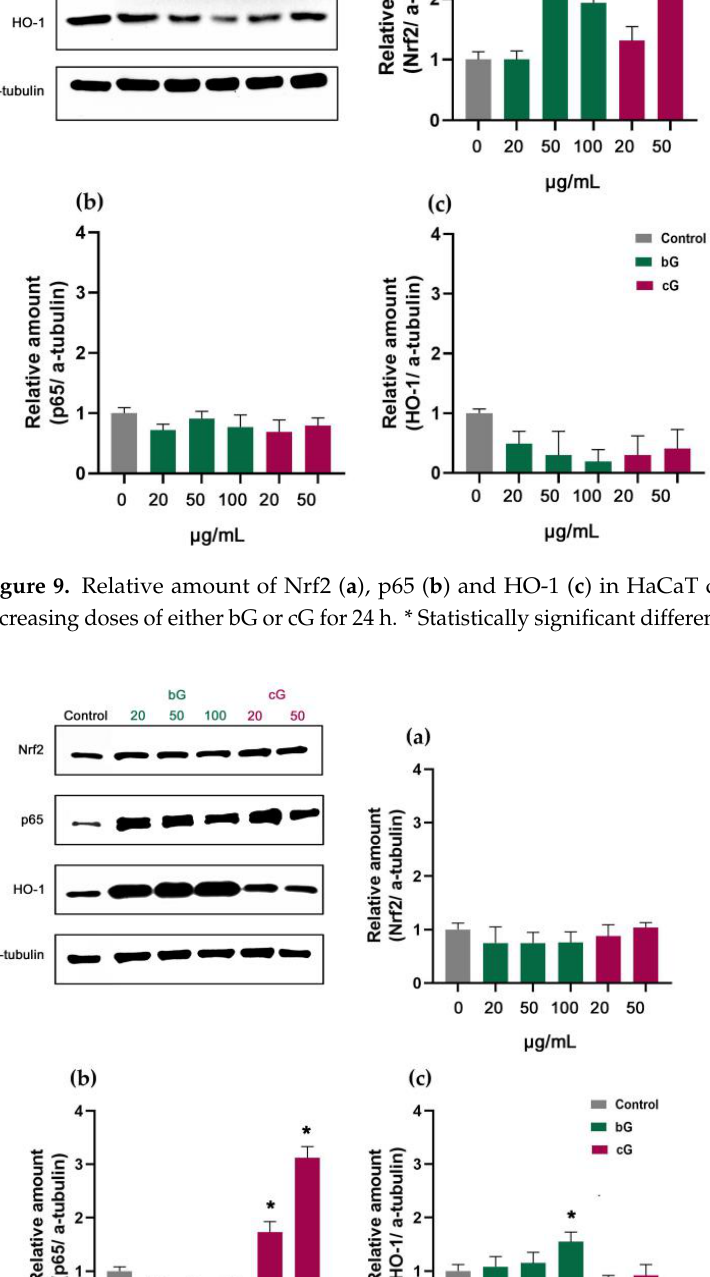
Figure 10. Relative amount of Nrf2 ( a ), p65 ( b ) and HO-1 ( c ) in THP-1 derived macrophages after treatment with increasing doses of either bG or cG for 24 h. * Statistically significant difference from control ( p < 0.05).